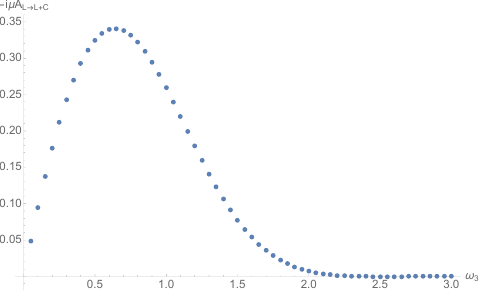
Figure 7 . Long string amplitude A L ! L + C (rescaled by (cid:22) ) evaluated at (cid:12)xed incoming long string energy (cid:15) 1 = 1 as a function of closed string energy ! 3